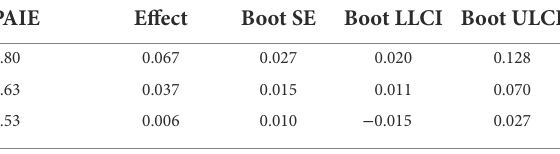
TABLE 7 Conditional indirect effects of X on Y.